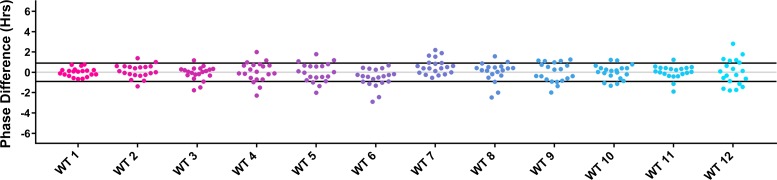
Phase distributions of control plants in U-box experiments.Values presented are the difference between the phase of the individual control plant and the average phase of the CCA1p::Luciferase control in the accompanying experiment. The grey line is at the average control value and the black lines are at ± the standard deviation of the control plants.